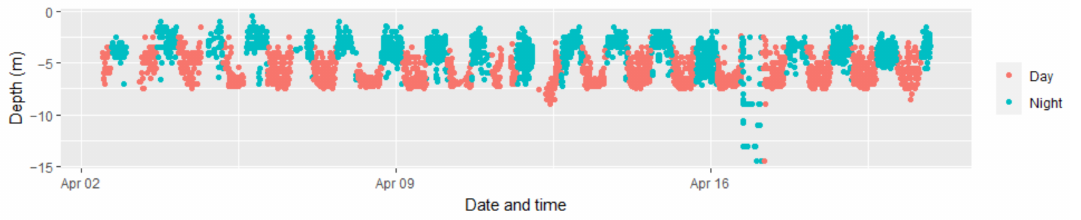
Figure A1. Depth data as was recorded in an archival tag of a Carcharhinus plumbeus male. Points are coloured according to the time of day (day in red, night in